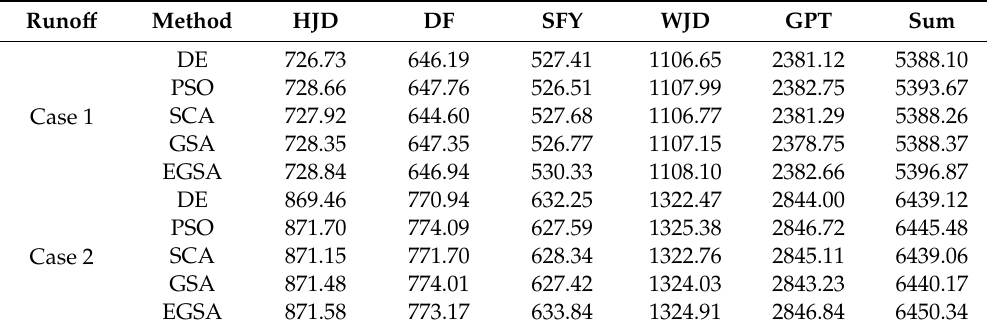
Table 6. Detailed results in the best solutions by different methods (10 4 kW·h).